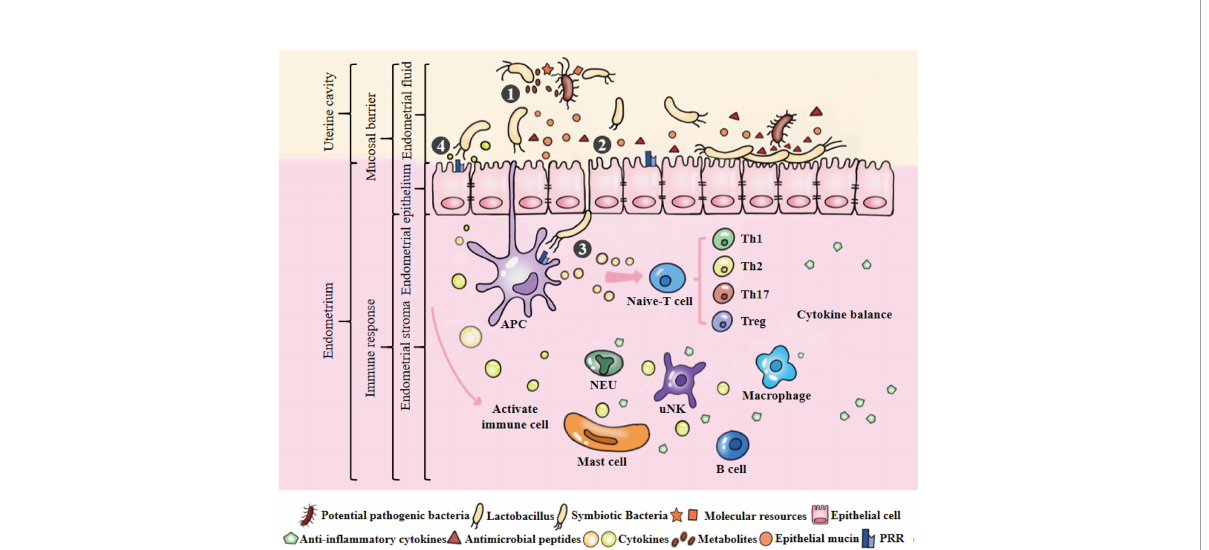
FIGURE 3 Microecological balance of the uterus. ① Symbiotic bacteria compete with pathogenic bacteria for molecular resources and occupy the uterine niche. They can also produce metabolites to kill bacteria. Among them, Lactobacillus plays an active role in maintaining the balance of endometrial microbiota. ② Endometrial monolayer columnar epithelial cells are closely connected to resist pathogenic bacteria, and produce natural antimicrobial peptides and mucins to strengthen this physical barrier under the stimulation of epithelial cells or symbiotic bacteria. ③ APCs can sense microbiota and initiate the signal cascade by combining their receptors with the PAMPs of symbiotic bacteria to induce the development, maturation, activation, proliferation and differentiation of immune cells. ④ Under the stimulation of model receptor, the production of cytokines may potentially coordinate the function and interaction of immune cells. Cytokines produced by immune cells can maintain a dynamic balance and involved in maintaining physiological functions of the uterus, such as defense against pathogenic bacteria, endometrial angiogenesis, endometrial repair and maternal-fetal immune